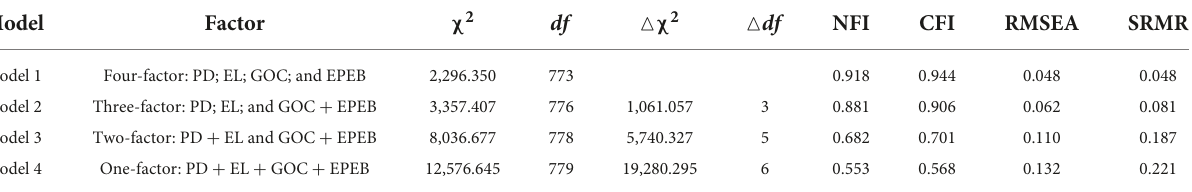
TABLE 3 Summary of model fit indexes.